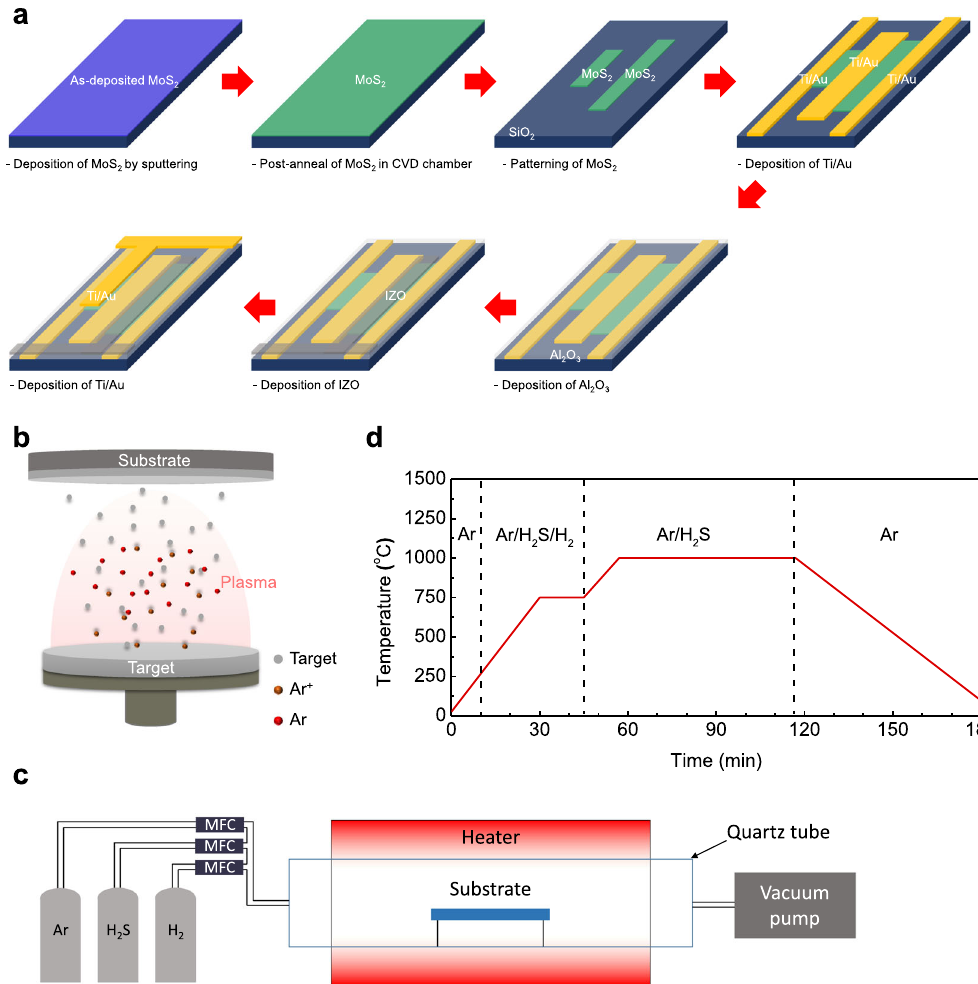
Fig. 2 Fabrication steps of the image sensor array based on bilayer MoS 2 fi lm. a Fabrication process of a pixel unit cell in the proposed active pixel image sensor array with a bilayer MoS 2 fi lm. Synthesis of a bilayer MoS 2 fi lm using a two-step growth method: MoS 2 sputtering ( fi rst step) and sulfurization in the CVD (second step). Schematic image of b RF magnetron sputtering and c CVD chamber composed of gas sources (Ar, H 2 S, H 2 ), quartz tube, heater, and vacuum pump. MFC is mass fl ow controller. d Temperature pro fi le and gas injection conditions for sulfurization as a function of time. The vertical dashed lines divide four regions with different gas